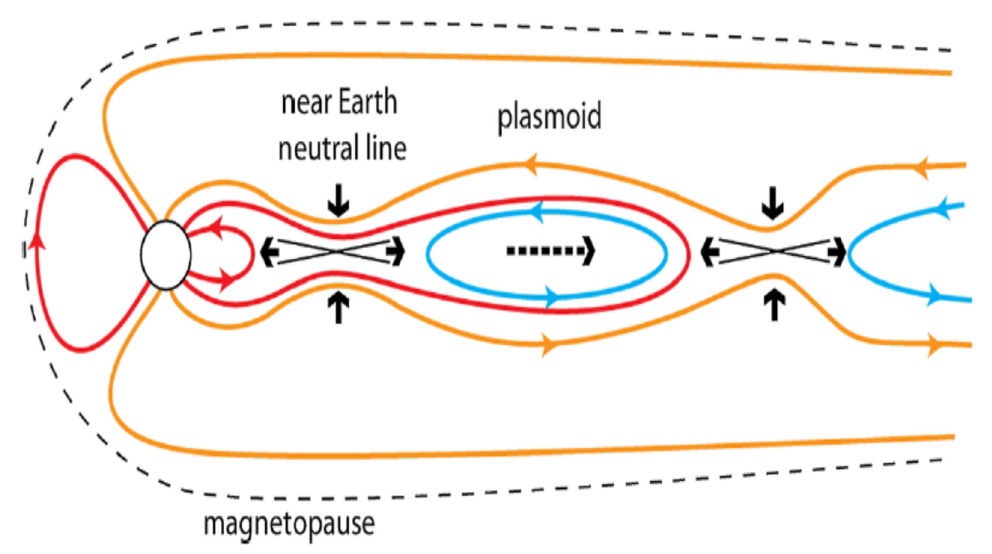
Figure 7. Formation of the near-Earth neutral line. This leads to the development of a plasmoid which is ejected down tail